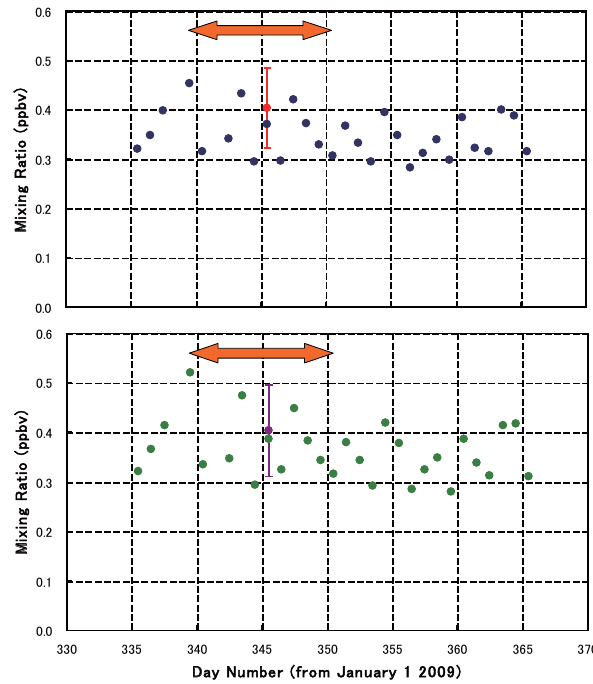
Fig. 8. Time series of daily average of the selected MLS ClO mixing ratio (within 12:00–15:00LT) over Atacama at 40km (top panel) and 45km (bottom panel), respectively. ClO mixing ratio derived from the averaged spectrum obtained by NATAOS radiometer is su- perposed. The arrow indicates the averaging period of the NATAOS measurement, from December 5 to 16,